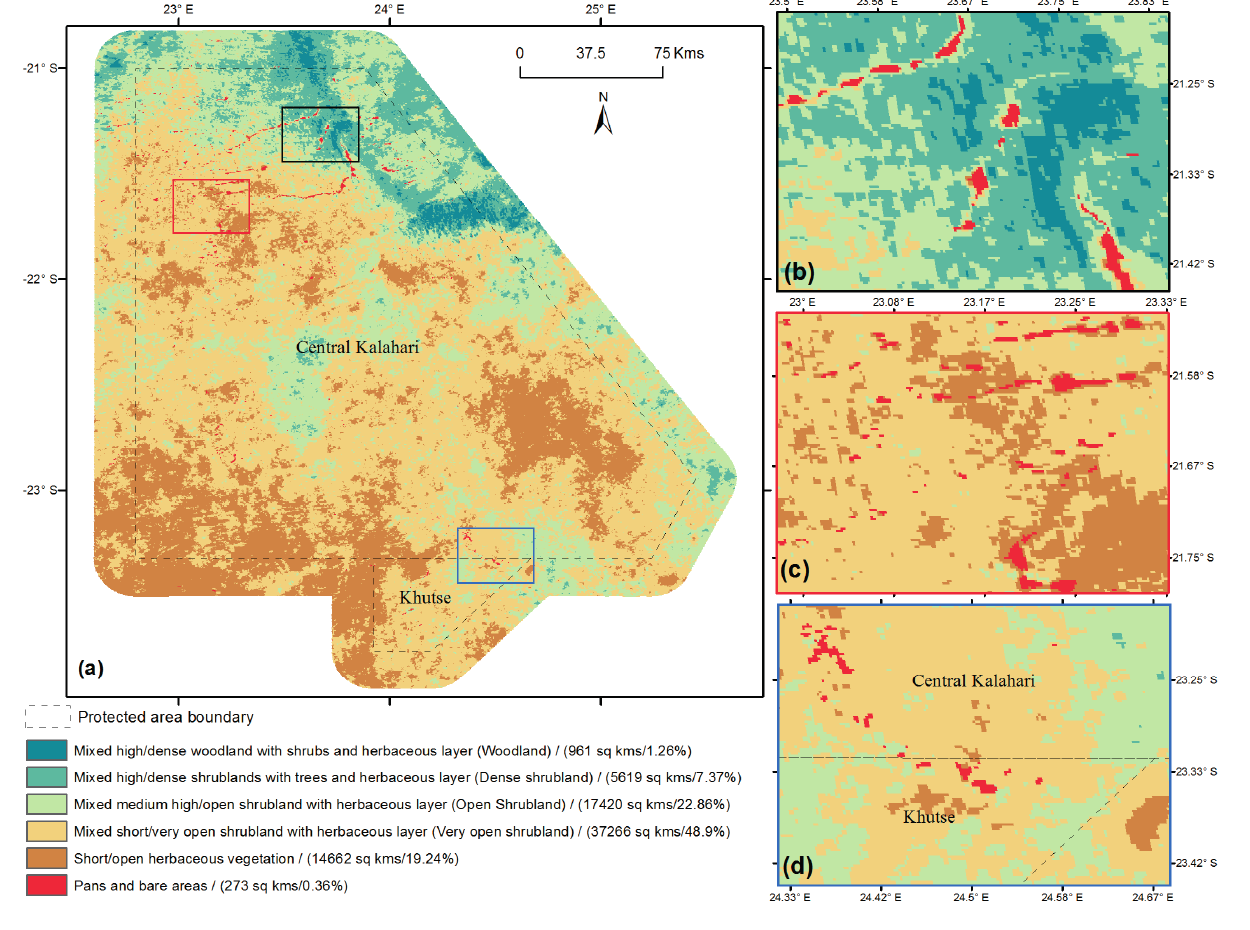
Figure 5. Vegetation morphology map of the central Kalahari produced as a result of this